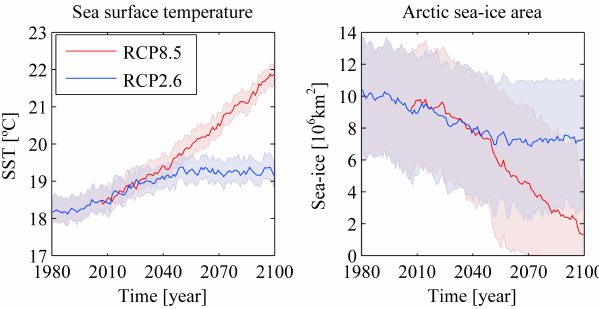
Fig. 8. The panels shows annual average (solid lines) and seasonal range (shaded regions) of sea surface temperature (left) and Arctic sea-ice area (right) for RCP 2.6 (blue) and RCP 8.5 (red).